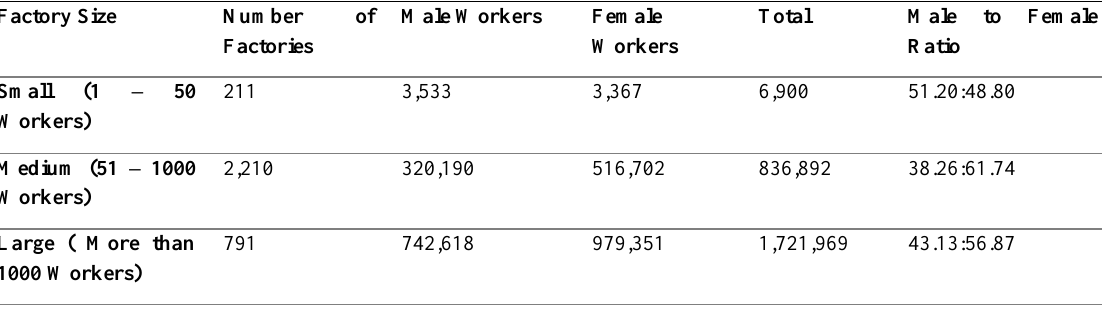
Table 4: Garments Factories and Garments Workers’ Ratio in terms of Factory